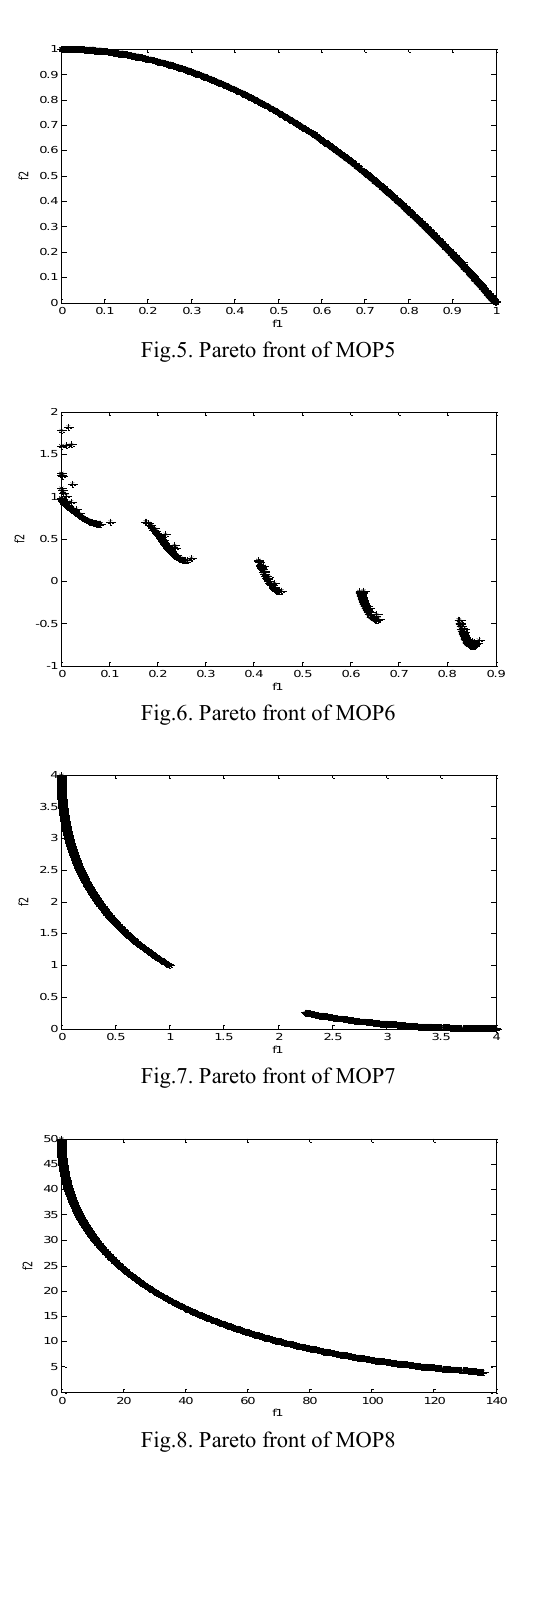
Fig.8. Pareto front of